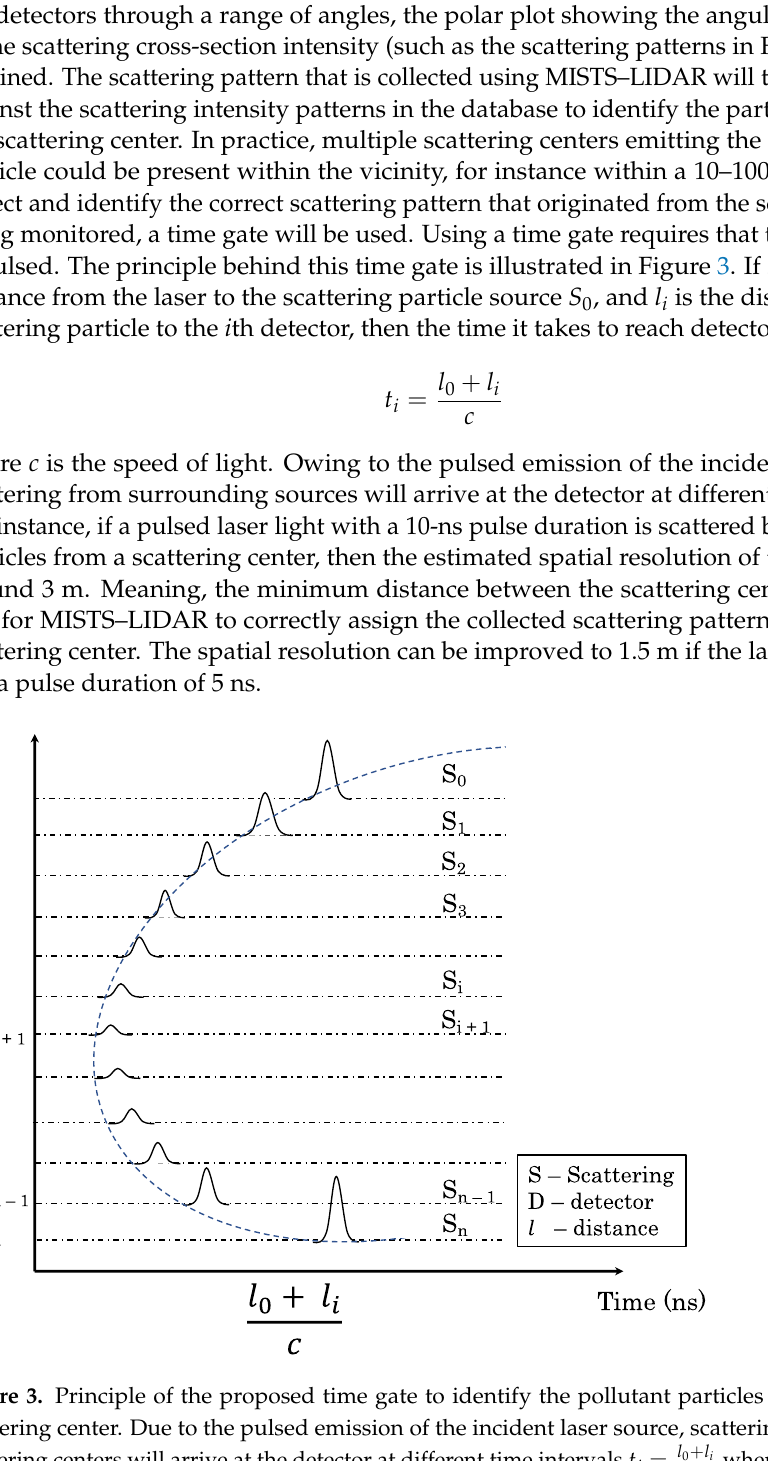
where l 0 is the where l 0 is the known 𝑐 c